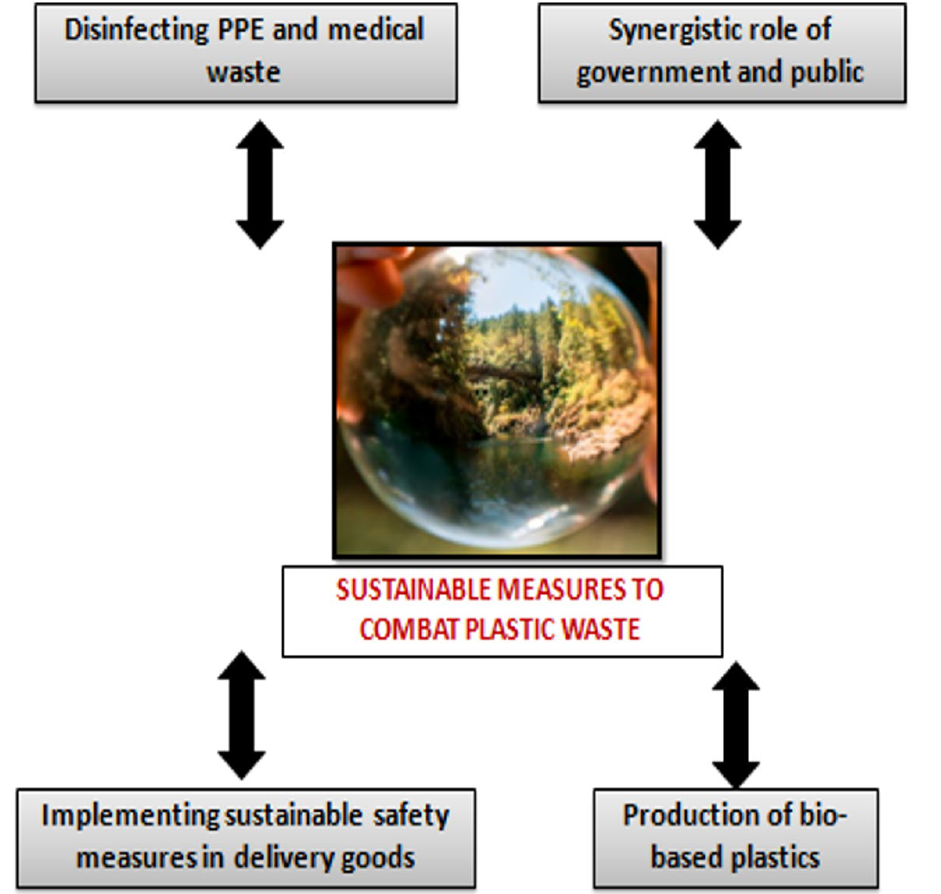
Fig. 4. Sustainable measures to overcome COVID-19 plastic waste